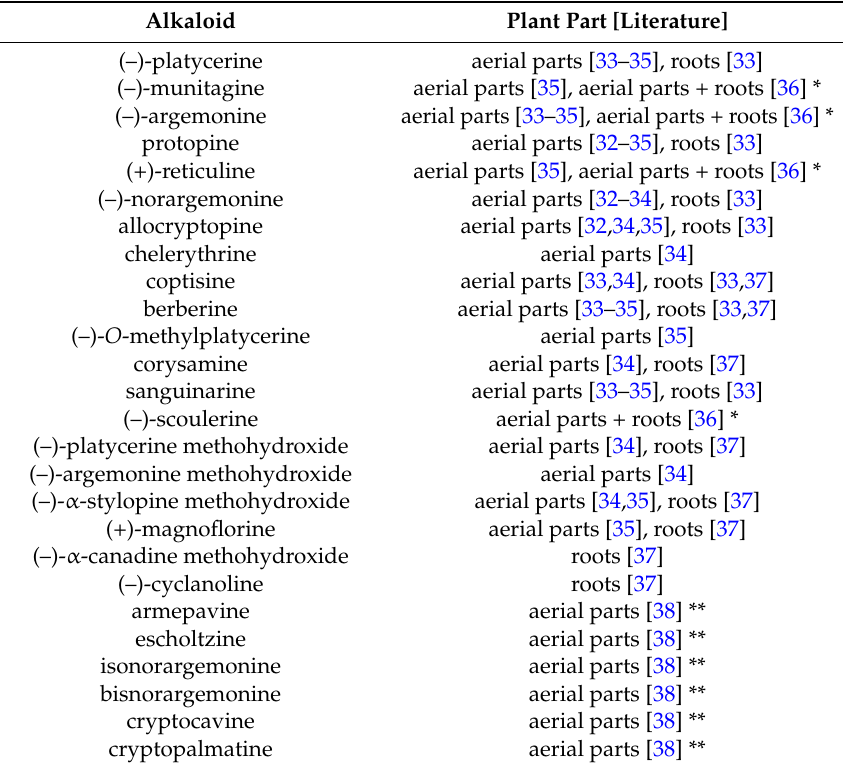
Table 1. Isoquinoline alkaloids isolated from A. platyceras Link et Otto so